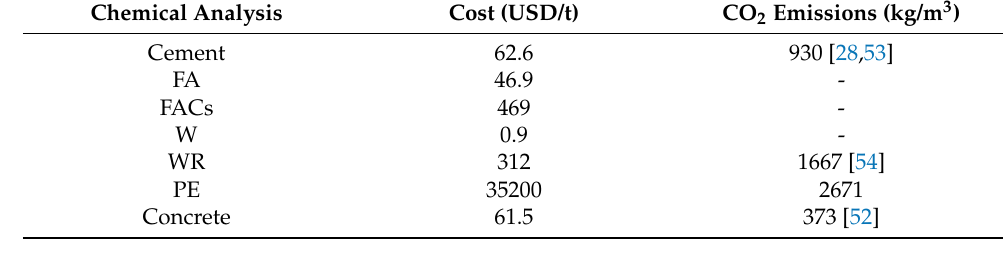
Table 5. Costs and CO 2 emissions of ECC raw materials.